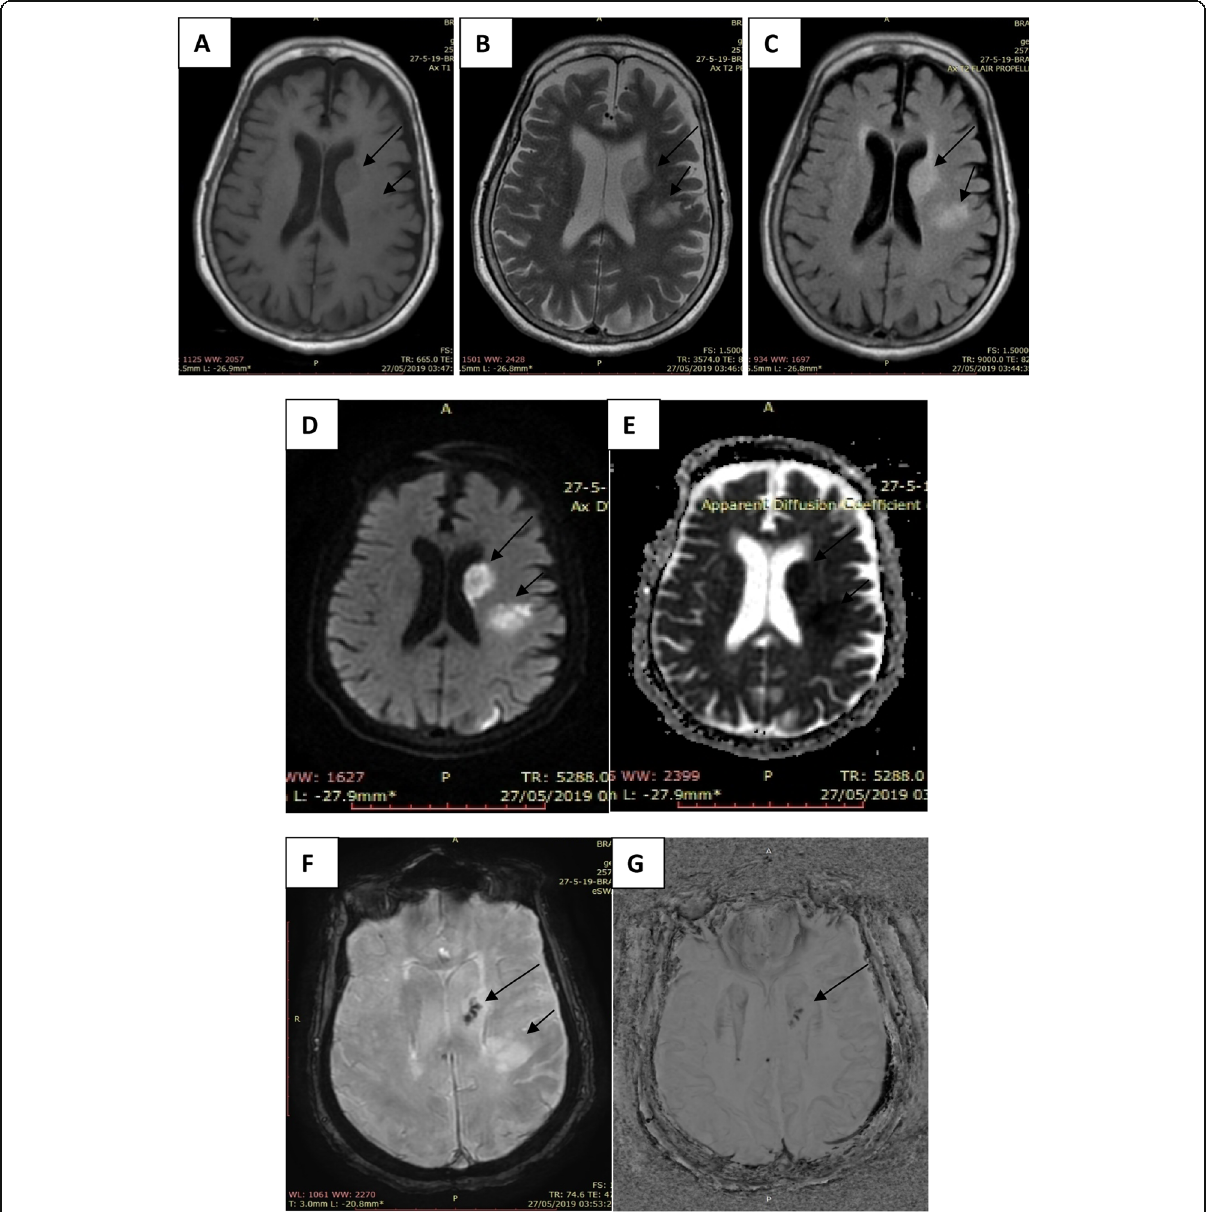
Fig. 4 Female patient aged 64 years old presented with hemiparesis and difficulty in speech. MRI brain showed left parietal acute infarction (short arrow) showing low signal intensity in T1WI ( a ) and high signal intensity in T2WI and FLAIR sequences ( b, c ) with restricted diffusion, hyperintense SI in diffusion ( d ), and hypointense SI in ADC ( e ), and no blooming effect in SWI ( f ) denoting non-hemorrhagic infarction together with another left basal ganglion (body of caudate) (long arrow) acute infarction with small dots of microhemorrhage seen inside by SWI ( f ) confirmed by low signal intensity in filter phase ( g ) denoting hemorrhagic infarction that was overlooked by